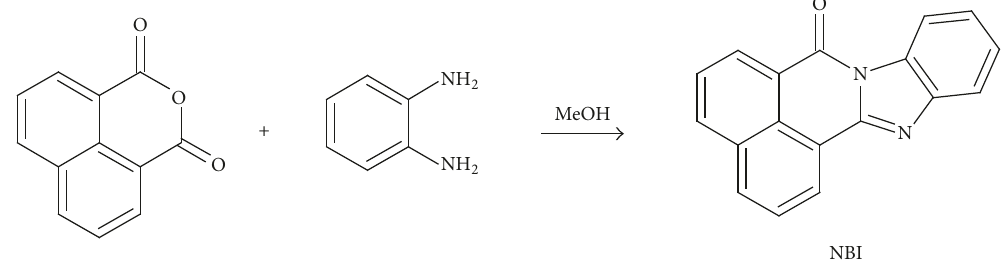
Scheme 1: Synthesis of the fluorescent probe NBI.